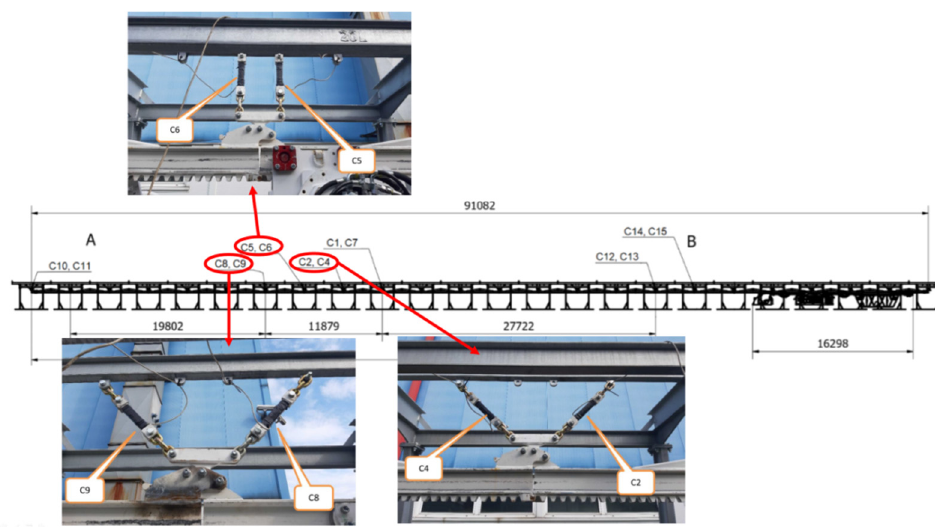
Figure 6. Arrangement of the force transducers on the measuring path: start of the ride (A), end of the ride (B) The time curves of forces in vertical suspensions are presented in Figure 7.